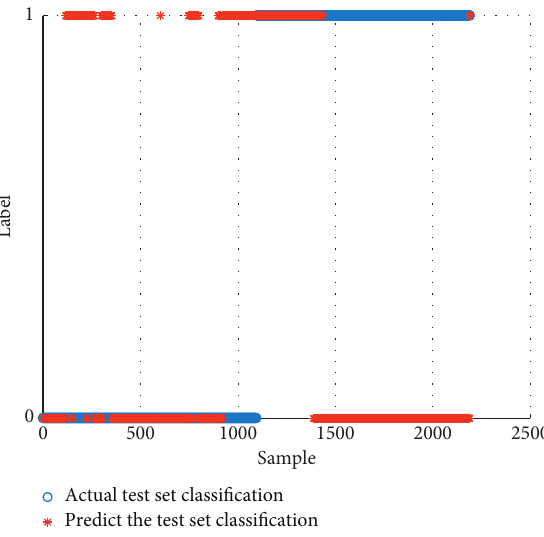
Figure 8: Case Western Reserve University bearing outer ring failure results based on